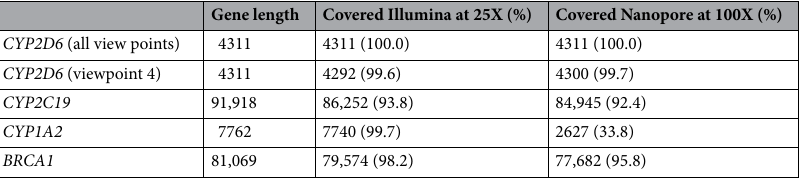
Table 3. Number of positions covered at the minimum depth, 25X for Illumina and 100X for Nanopore.